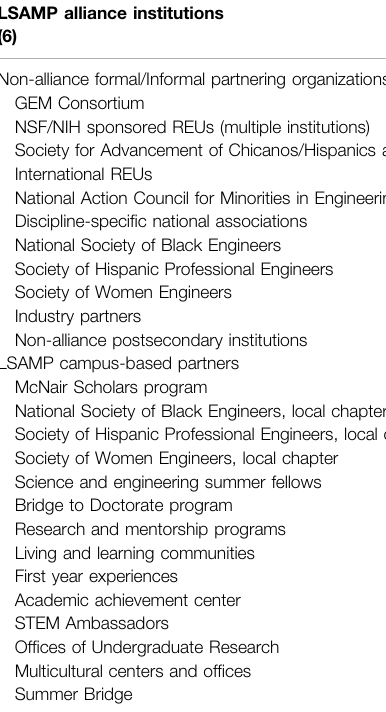
TABLE 1 | Interorganizational LSAMP